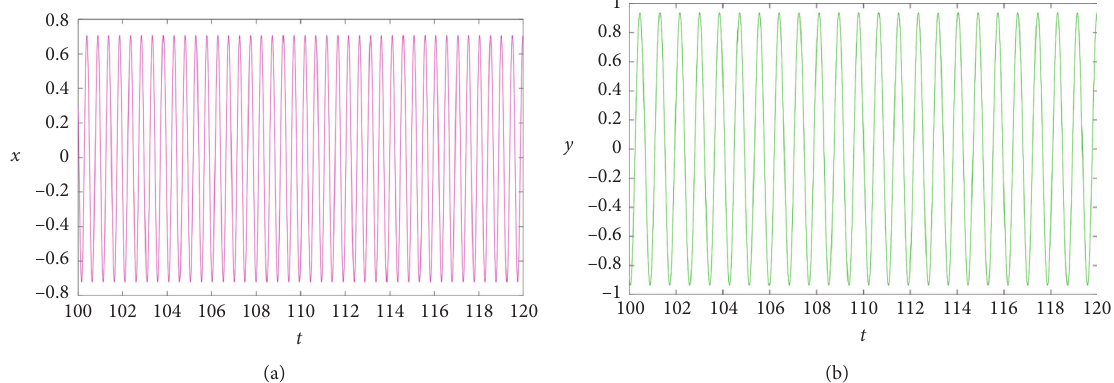
Figure 2: Time history diagrams with respect to (a) x and (b) y , respectively, when μ � 0 . 0123.